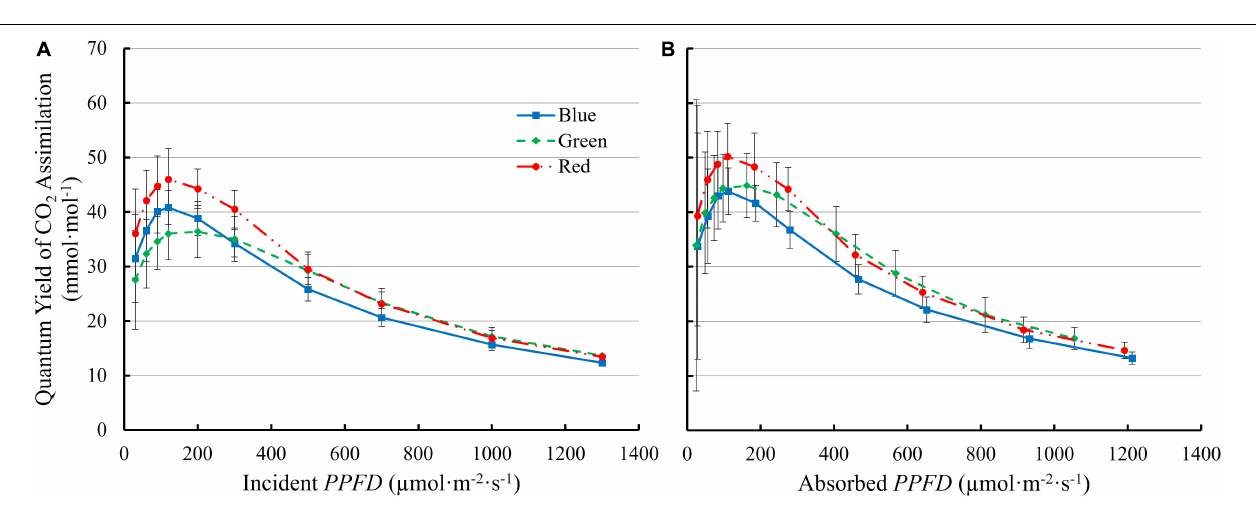
FIGURE 6 | The quantum yield of CO 2 assimilation of “Green Towers” lettuce as a function of incident ( QY inc ) (A) and absorbed PPFD ( QY abs ) (B) under blue, green, and red LED light. Error bars represent the standard deviation ( n =